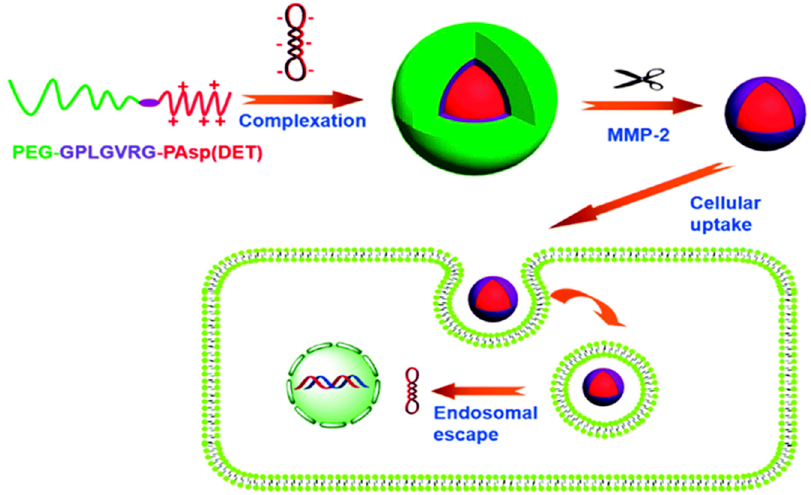
Figure 5 . Schematic illustration showing PEG-coated polyplex micelles in MMP-2-expressing tumor tissue showing enhanced cellular uptake and endosomal escape for gene transfection. Reproduced with permission from [107]. Copyright proceedings from The Royal Society of Chemistry.